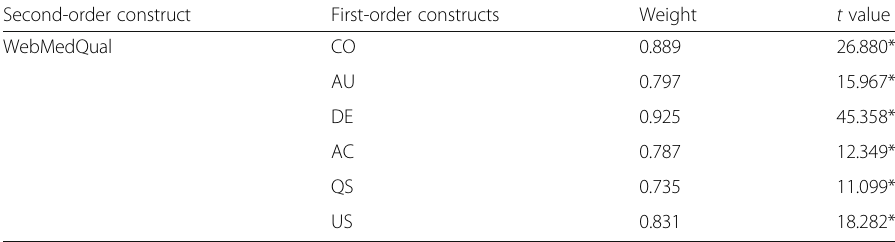
Table 4 Weights of the first-order constructs on the designated second-order construct Second-order construct